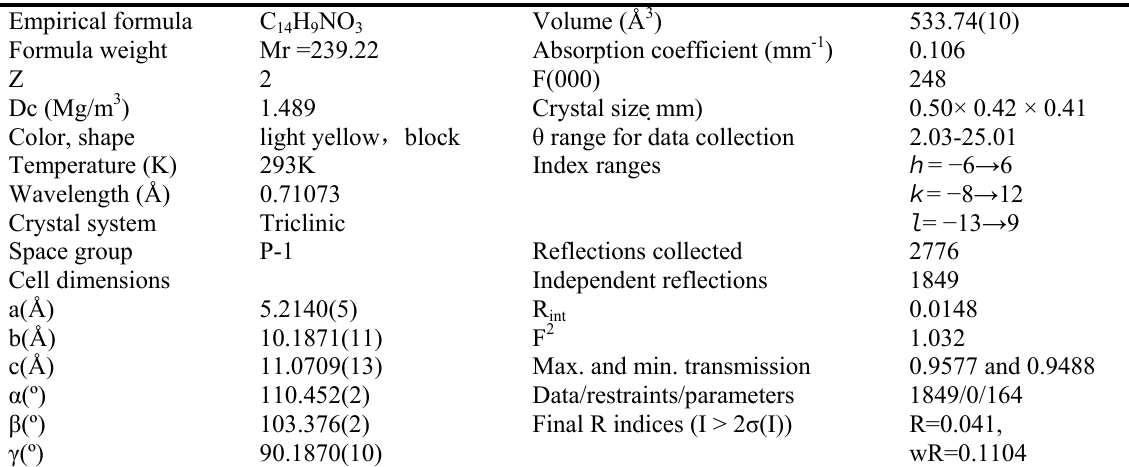
Table 1. Crystal Data and Structural